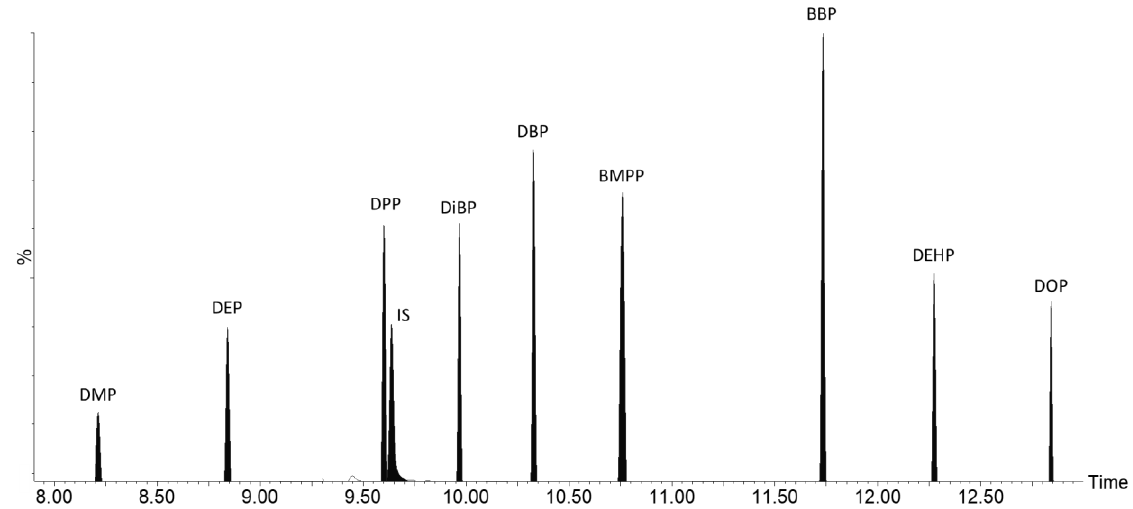
Figure 3. Chromatogram showing the main MRM transition for the nine phthalates and the